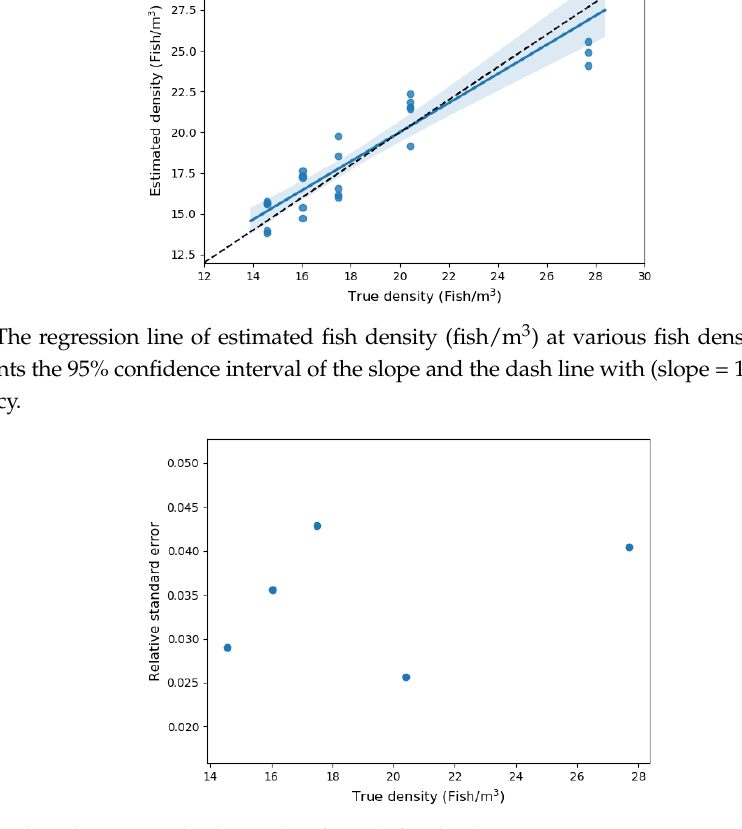
Figure 21. The relative standard error (SE/mean) for the density estimation at various fish